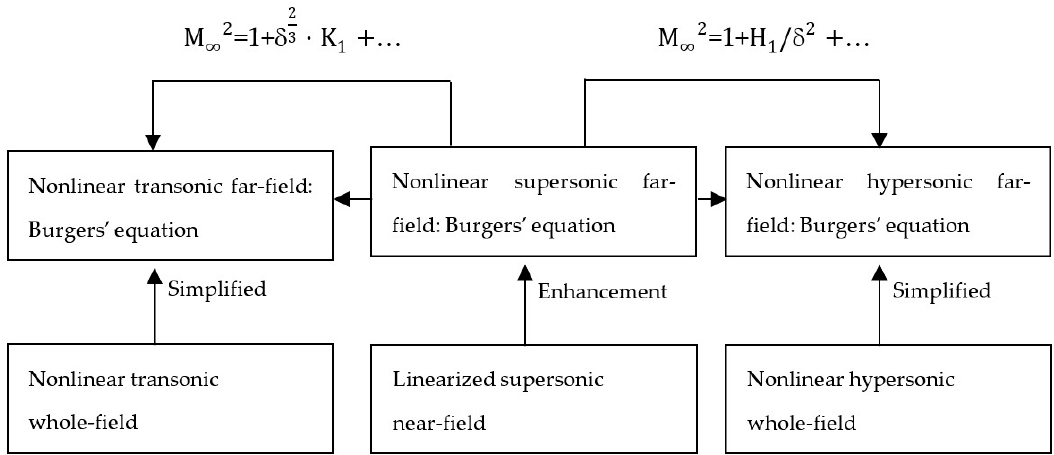
Figure 3. Mathematical relationship among different high-speed 2D flows. Table 1. Unified Burgers’ equation in the far field according in different flow regimes.